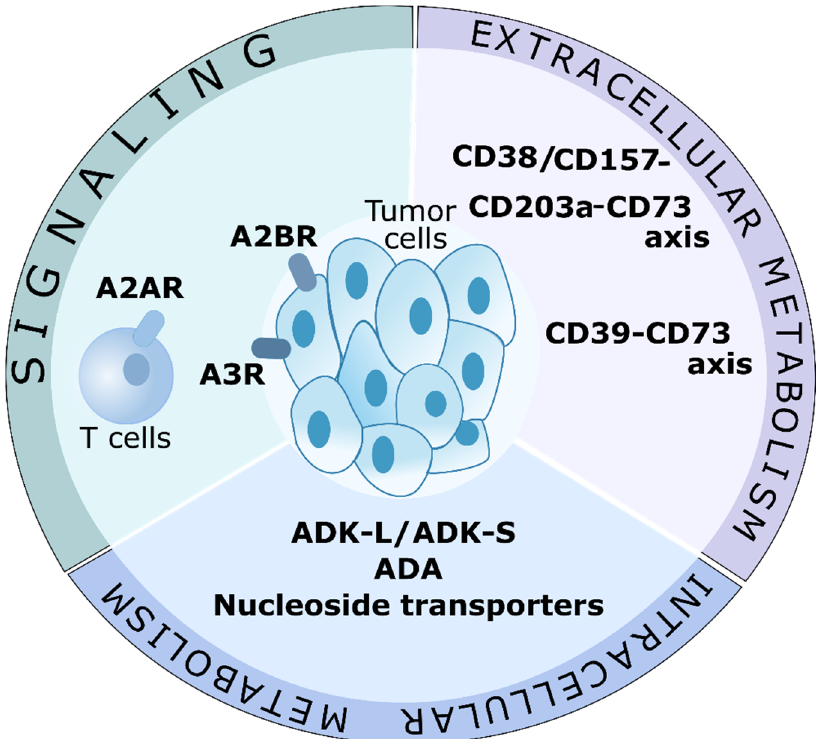
Figure 3. Targeting adenosine in cancer therapy. Possible adenosine-associated targets for cancer therapy. Signaling, and extracellular and intracellular metabolism may be involved in limiting the immunosuppressive action of adenosine. Possible therapeutic targets are A2A receptors (A2AR) on T cells, and A2B and A3 receptors on tumor cells. Like a part of the extracellular metabolism, the CD39-CD73 axis and the CD38/CD157-CD203a-CD73 axis are actively investigated in clinical trials. Targeting adenosine-cleaving enzymes, ADK and ADA, as well as nucleotide transporters, may become a new direction in cancer therapy. Of particular interest is ADK-L, which is involved in epigenetic regulation.